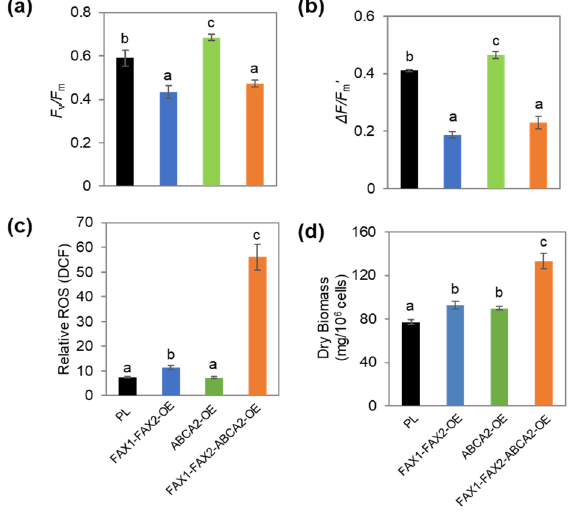
Figure 5. Phenotypic changes in transformants under N starvation conditions. ( a ) Maximum quantum efficiency of PS II ( F v /F m ). ( b ) Effective capability of PS II ( Δ F/F m ′ ). ( c ) Reactive oxygen species (ROS) content. ( d ) Biomass content. Cells were harvested after N starvation for 48 h. Error bars represent standard errors based on four biological replicates. Statistically significant difference by Tukey’s HSD test was indicated by distinct letters.